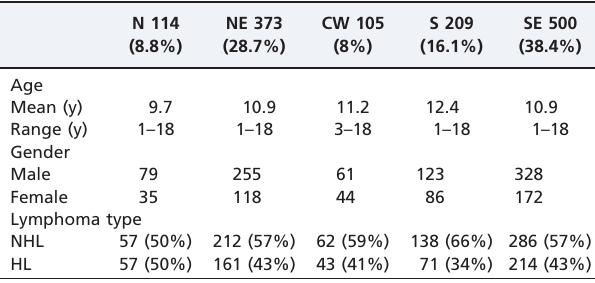
Table 2 - Overview of all cases of pediatric lymphomas distributed by geographic region according to mean age, age range, gender, and lymphoma subtype.